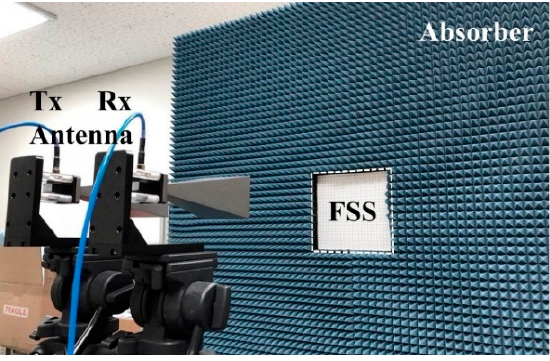
Figure 5. Frequency reflection characteristic measurement setup. Sensors 2018 , 18 , x FOR PEER REVIEW